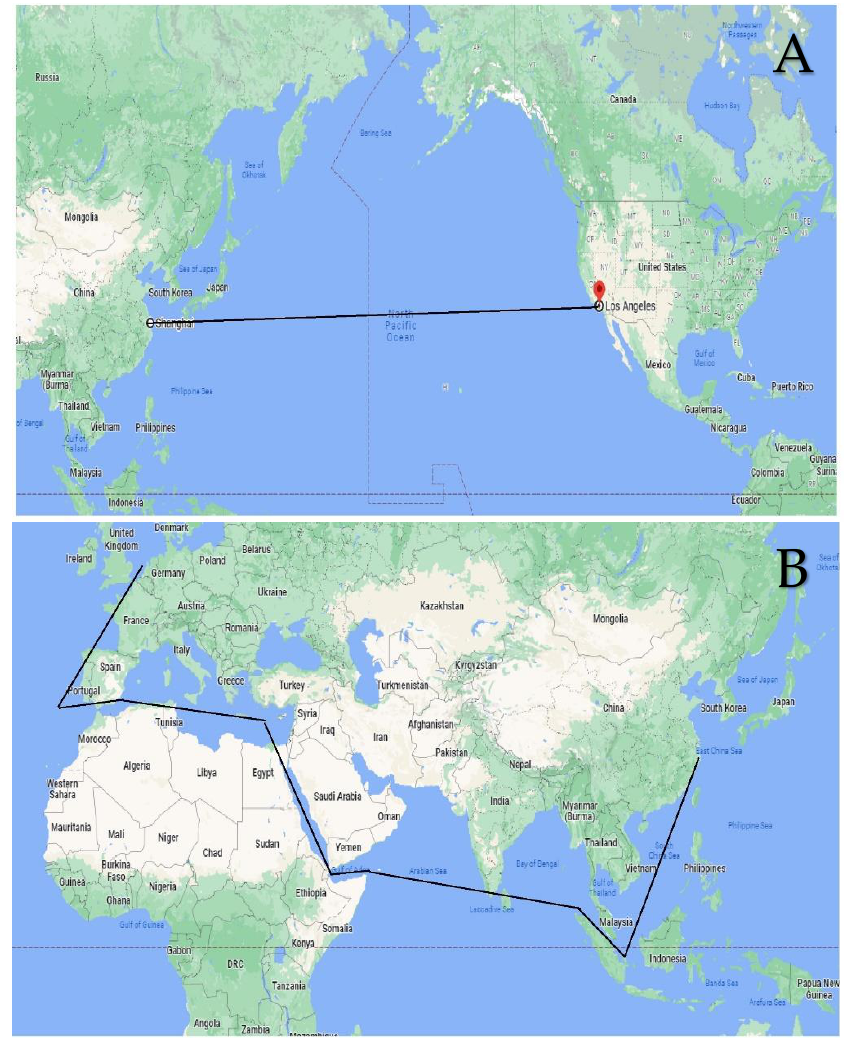
Figure 3. ( A ) The first journey route Shanghai, China, to Los Angeles, USA; ( B ) the second journey was from Shanghai, China, to Hamburg, Germany.